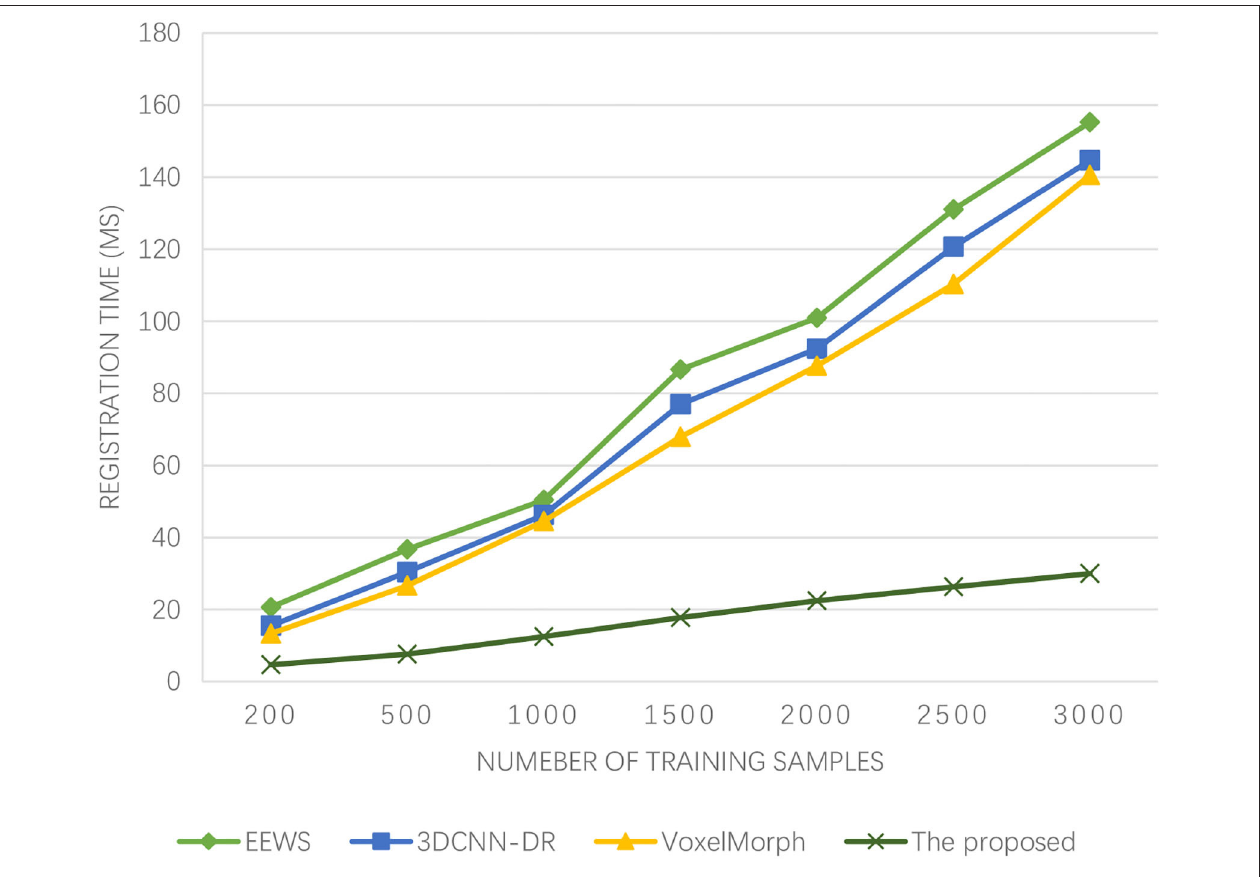
FIGURE 4 | Experimental results of registration